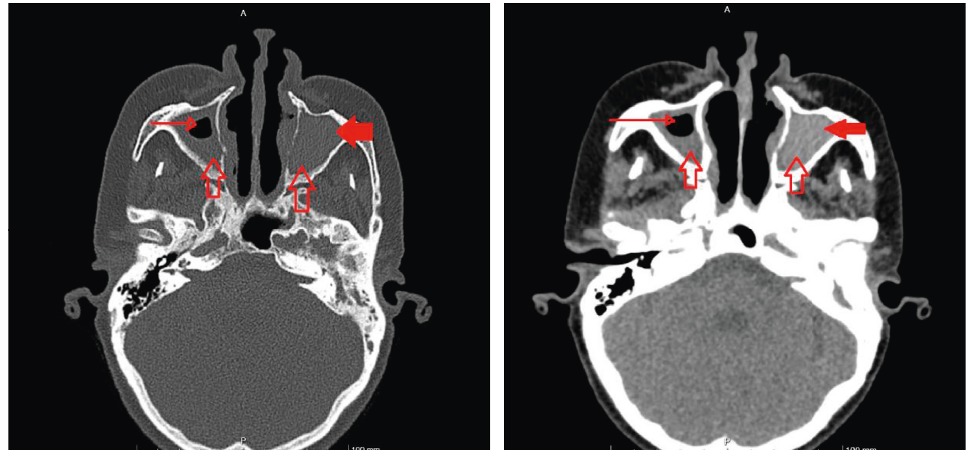
Figure 1: Axial paranasal CTshowed significant hyper-density in both maxillary sinuses (arrows) with completely obliterated left maxillary sinus (dense arrow) and air-fluid level within right maxillary sinus (small arrow) likely related to an underlying infection.